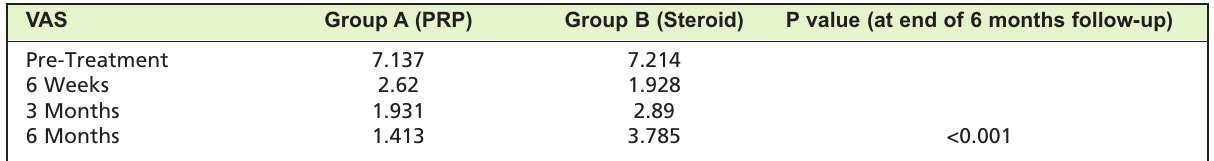
Mean VAS score in both groups Table II: